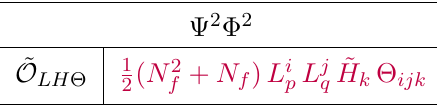
Table 32 . SM extended by SU(2) Quadruplet Scalar ( Θ ): additional operators of dimension 5. Here i, j, k are the SU(2) indices and p, q = 1 , 2 , · · · , N f are the flavour indices. The operator violates lepton